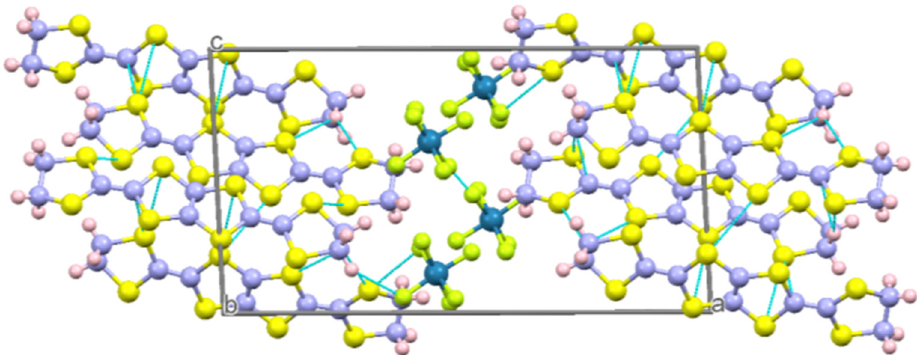
Figure 1. Crystal structure of the κ -(BDH-TTP) 4 ReF 6 ( 1 ) salt projected on the ac -plane. Dashed lines show shortened intermolecular contacts between the BDH-TTP molecules. Between the dimers there are four short S…S contacts and one short S…C contact, and the contacts involving hydrogen atoms (Table 1), while inside the dimers in the conducting layers, are only intermolecular contacts of the types S…HC (S5…H9A) and C…HC (C6…H9A).